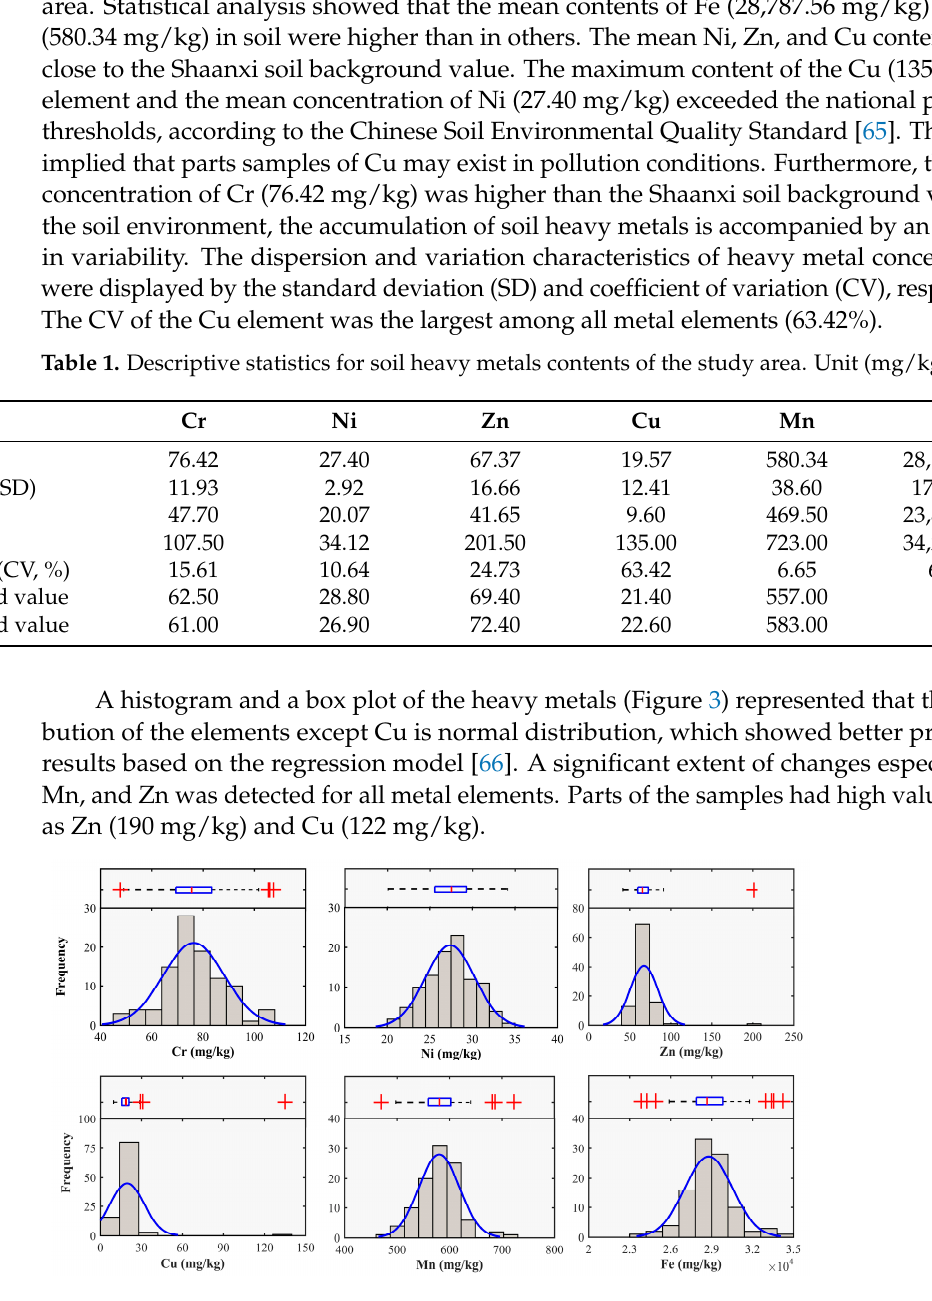
Figure 4. Histograms and box plots of heavy metal contents of the samples in the study area. Note: The red crosses delegate outliers, the red lines inner the blue rectangular represent median value, and the vertical sides of the blue rectangular are quartiles .